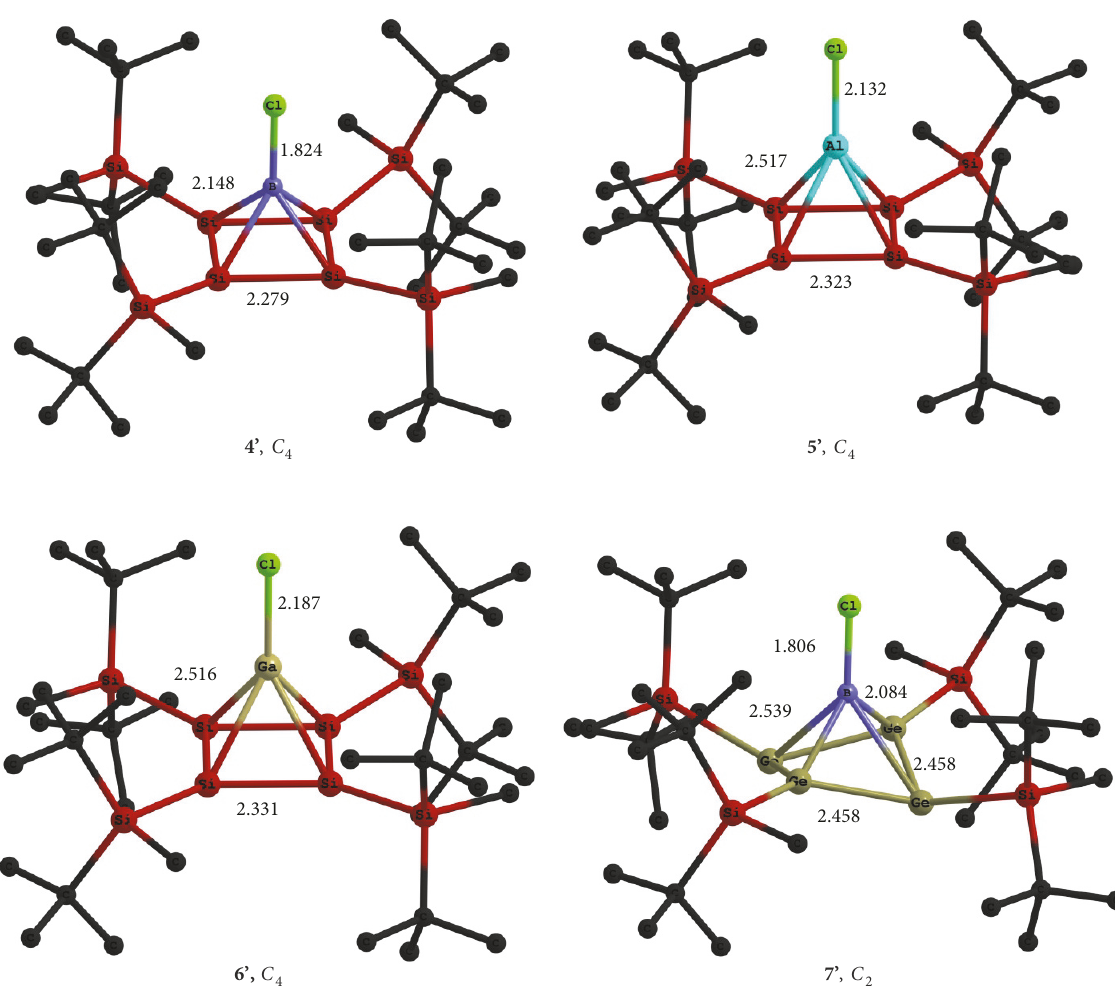
Figure 4: Optimized geometries (bond lengths are in ˚A) of minima structures 4 󸀠 –7 󸀠 . Hydrogen atoms are omitted.